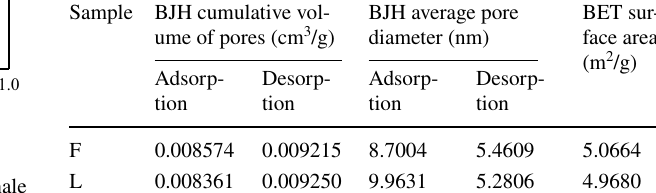
2 adsorption–desorption isotherms of shale